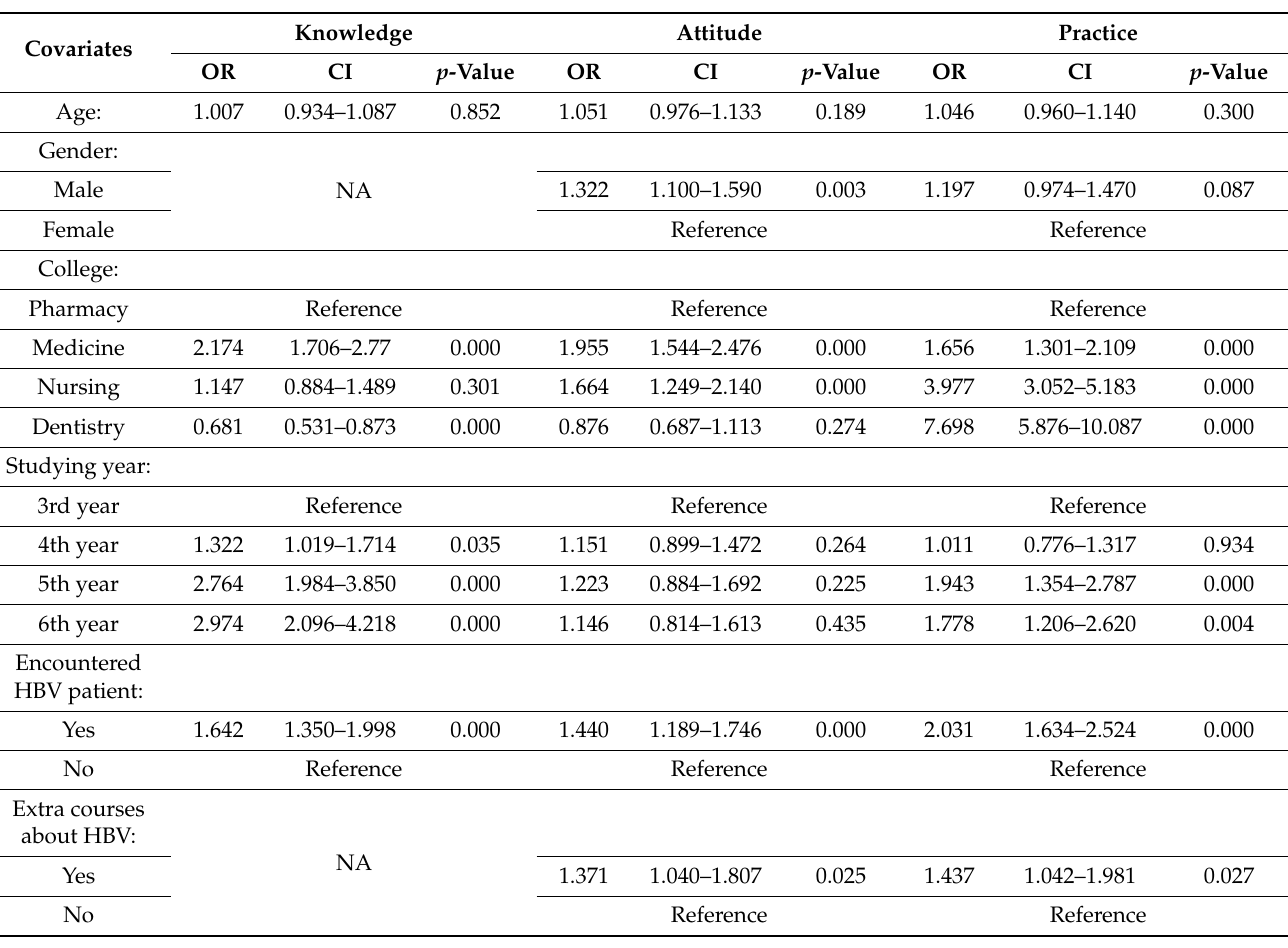
Table 3. Logistic regression analysis between demographic characteristics of healthcare students and knowledge, attitudes, and practices toward